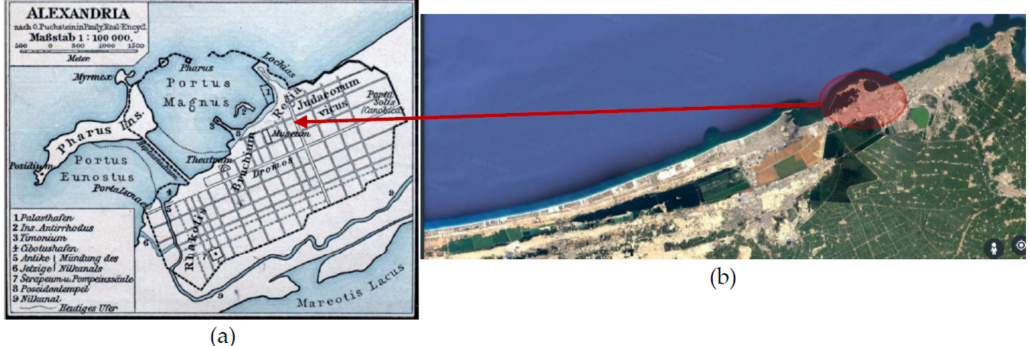
Figure 1. Maps for Alexandria ( a ) Historic map of Alexandria showing the Heptastadion (ancient Alexandria). Source: [24]. ( b ) Alexandria. Current expansion showing the area of Heptastadion highlighted. Source: Google Earth.